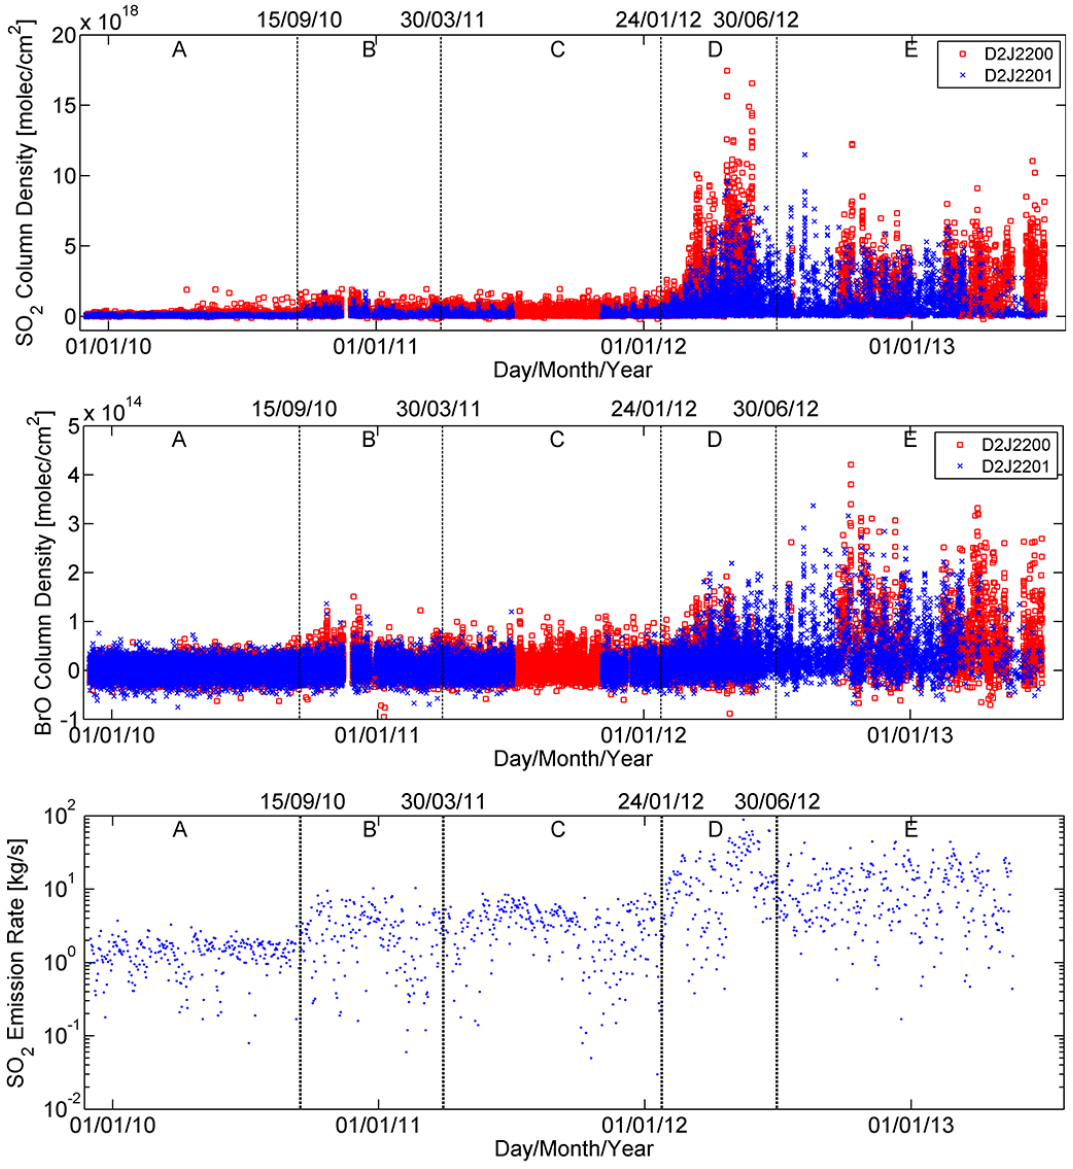
Figure 9. Time series from the two instruments at Nevado del Ruiz. The instrument D2J2200 is located in a way that measures elevated SO 2 and BrO column density values more frequently (see Fig. 1). The spectra evaluated were created from co-adding reference and plume spectra from four consecutive scans. Top: SO 2 CDs; centre: BrO CDs; bottom: Daily averages of the SO 2 emission rates. The wind speed was taken from the ECMWF database. More details are available in Galle et al. (2010) and Arellano